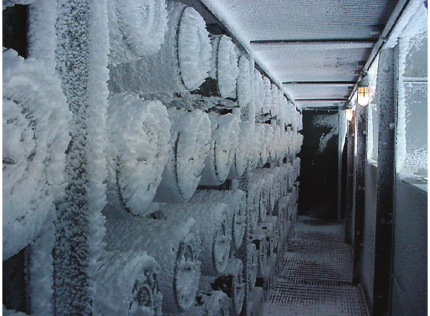
Figure 5: Pulse cartridge filters with frost build up due to cooling tower drift [29].